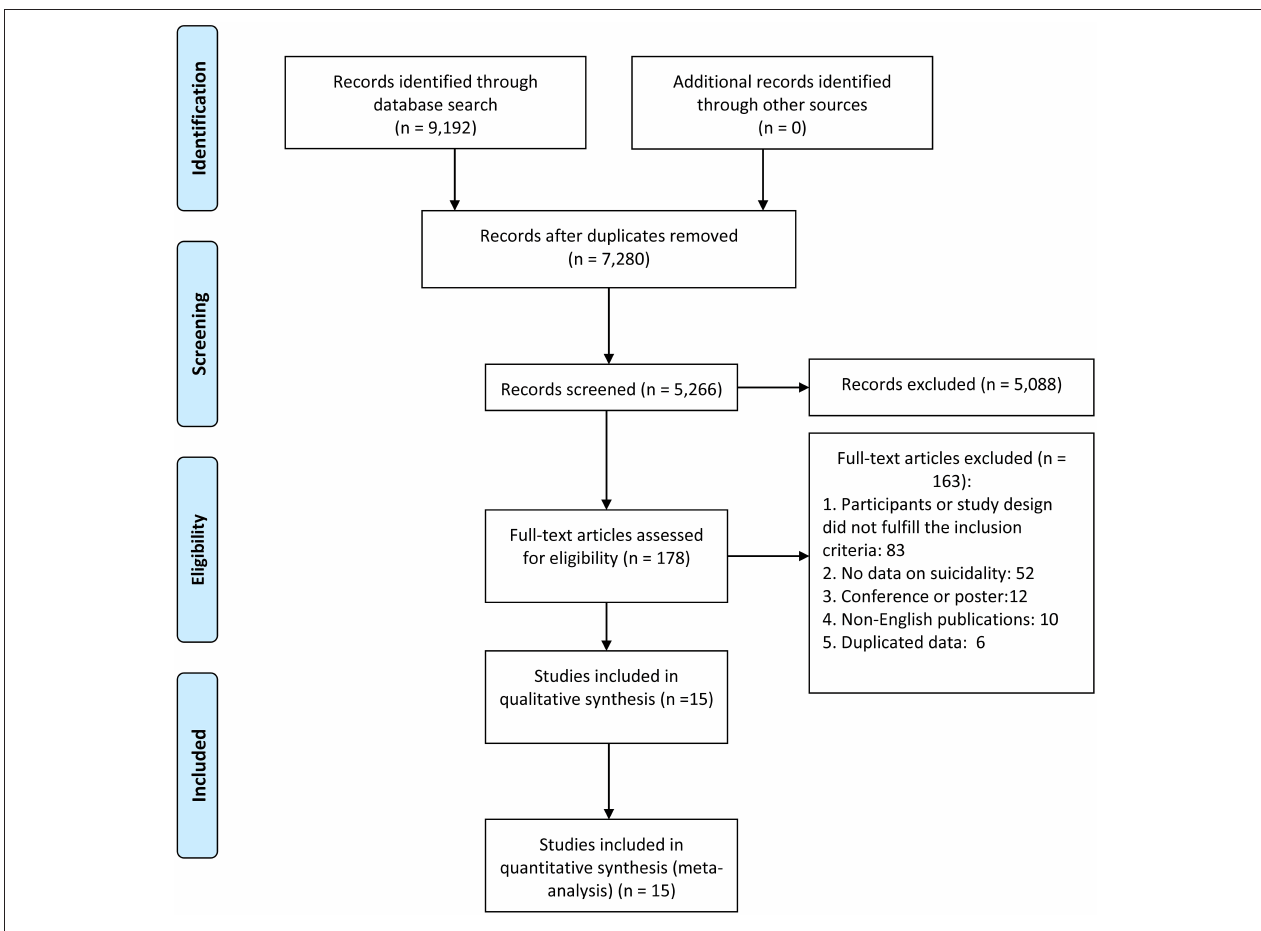
FIGURE 1 | Flow chart of study